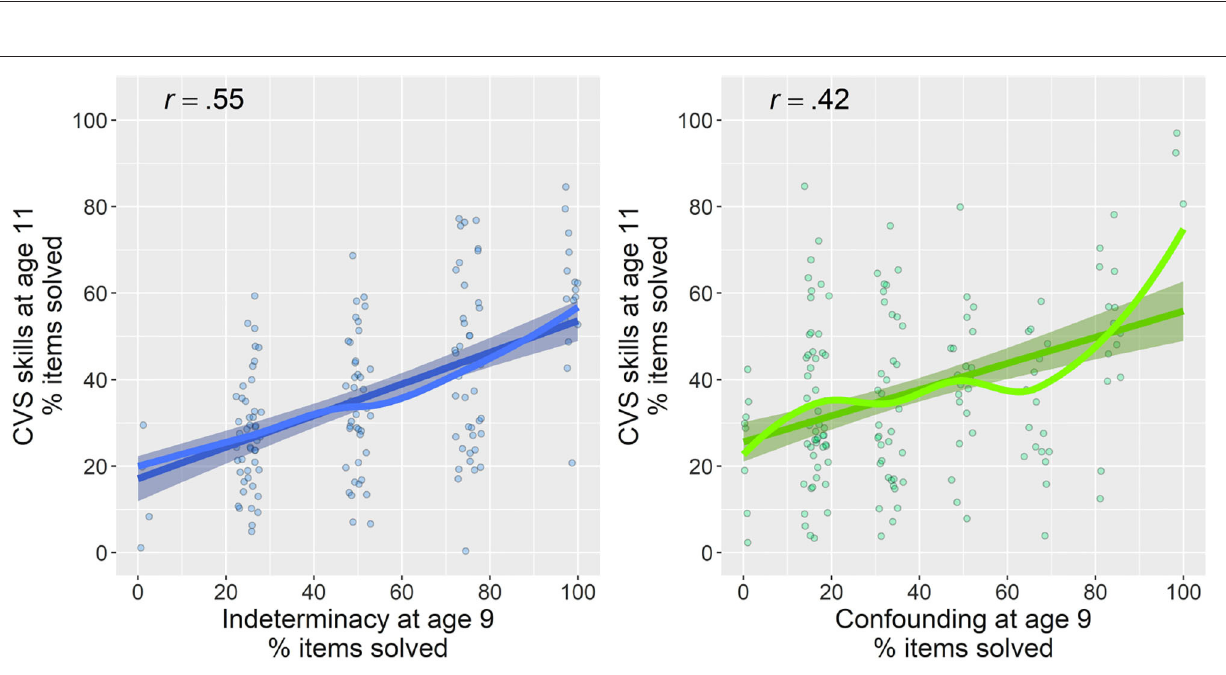
Frontiers in Psychology | www.frontiersin.org